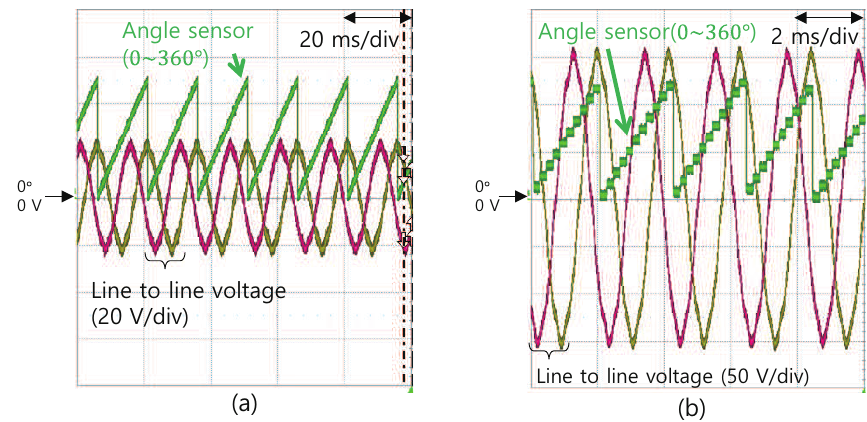
Figure 11. Back EMF waves: ( a ) 1000 rpm and ( b ) 7000